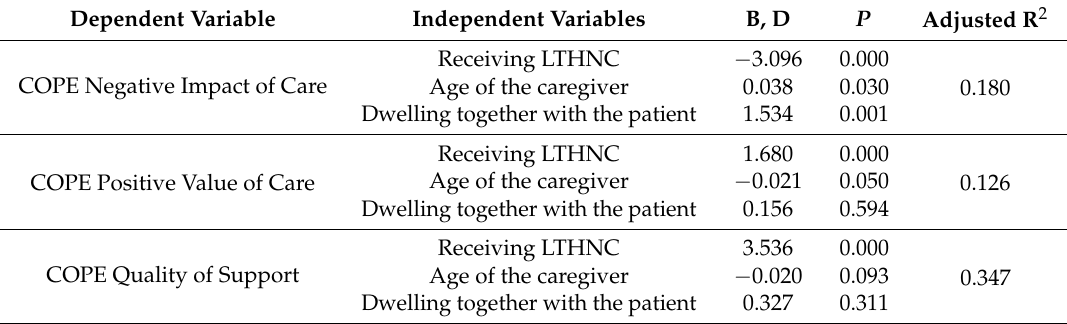
Table 2. Relationship between receiving LTHNC and COPE index subscales (multivariate models adjusted for place of residence and age of